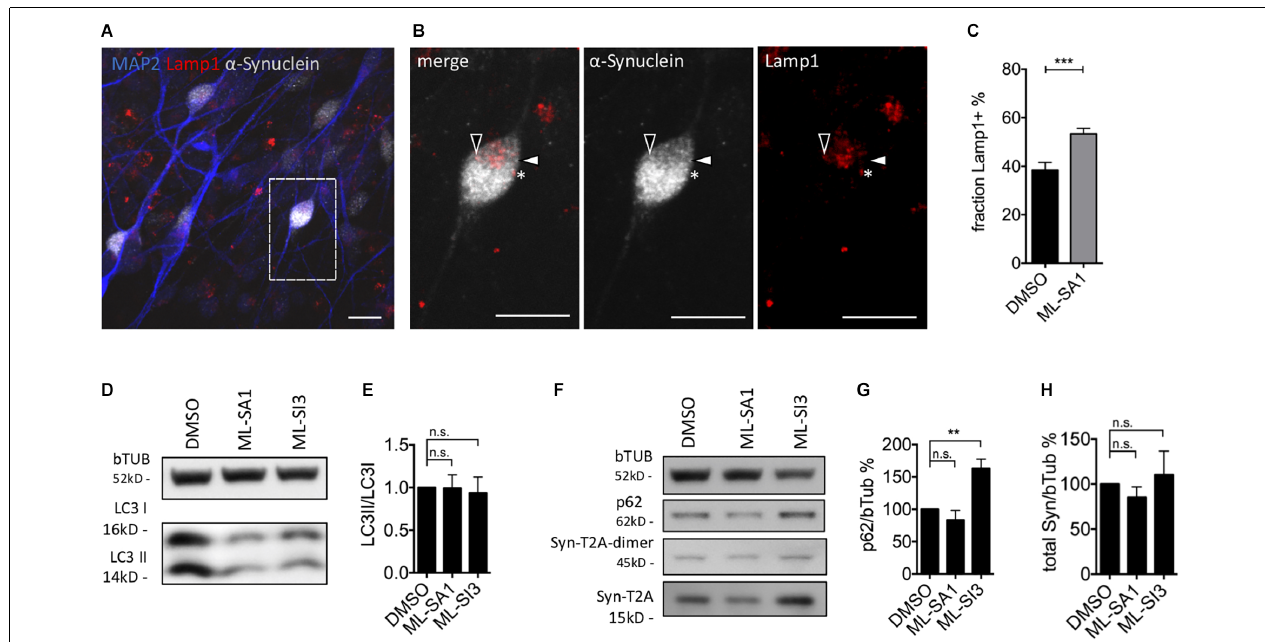
FIGURE 7 | Effect of TRPML1-agonist ML-SA1 and TRPML1-antagonist ML-SI3 on autophagy and α -synuclein particles in human dopaminergic neurons. (A) Example images of LUHMES-derived dopaminergic neurons transduced with α -synuclein-T2A-GFP-lentivirus. Six days after transduction neurons were treated for 24 h either with DMSO or 10 µ M ML-SA1. Neurons were further stained against human α -synuclein, lysosomal marker Lamp1 and neuronal marker using MAP2. The scale bar represents 20 µ m. (B) Close up of (A) . Closed arrowhead marks a α -synuclein-positive/Lamp1-negative particle, open arrowhead marks a α -synuclein-positive and Lamp1-positive particle, asterisk marks a α -synuclein-negative/Lamp1-positive lysosome. (C) Percentage of Lamp1-positive synuclein particles per neuron. Results of 30 cells per condition. Unpaired t -test depicted with respect to DMSO ( p < 0.001). (D) Representative immunoblot of lysates from transduced LUHMES-derived neurons on day 9, treated with DMSO, ML-SA1 10 µ M, or ML-SI3 10 µ M for 2 h. Full blot shown in Supplementary Figure 5A . (E) Quantification of the LC3II band relative to LC3I band in n = 3 independent experiments as in (D) . One-way ANOVA showed no significance ( p = 0.8). (F) Representative immunoblot of lysates from transduced LUHMES-derived neurons on day 9, treated with DMSO, ML-SA1 10 µ M or ML-SI3 10 µ M for 24 h. Full blot shown in Supplementary Figure 5D . (G) Quantification of the p62 band relative to beta-Tubulin in n = 3 independent experiments as in (F) . One-way ANOVA showed significance ( p < 0.01). Dunnet’s multiple comparisons test is depicted with respect to DMSO. (H) Quantification of Synuclein load relative to beta-Tubulin in n = 3 independent experiments as in (F) . One-way ANOVA showed no significance ( p = 0.2). ** p < 0.01, *** p < 0.001, non-significant differences are depicted as